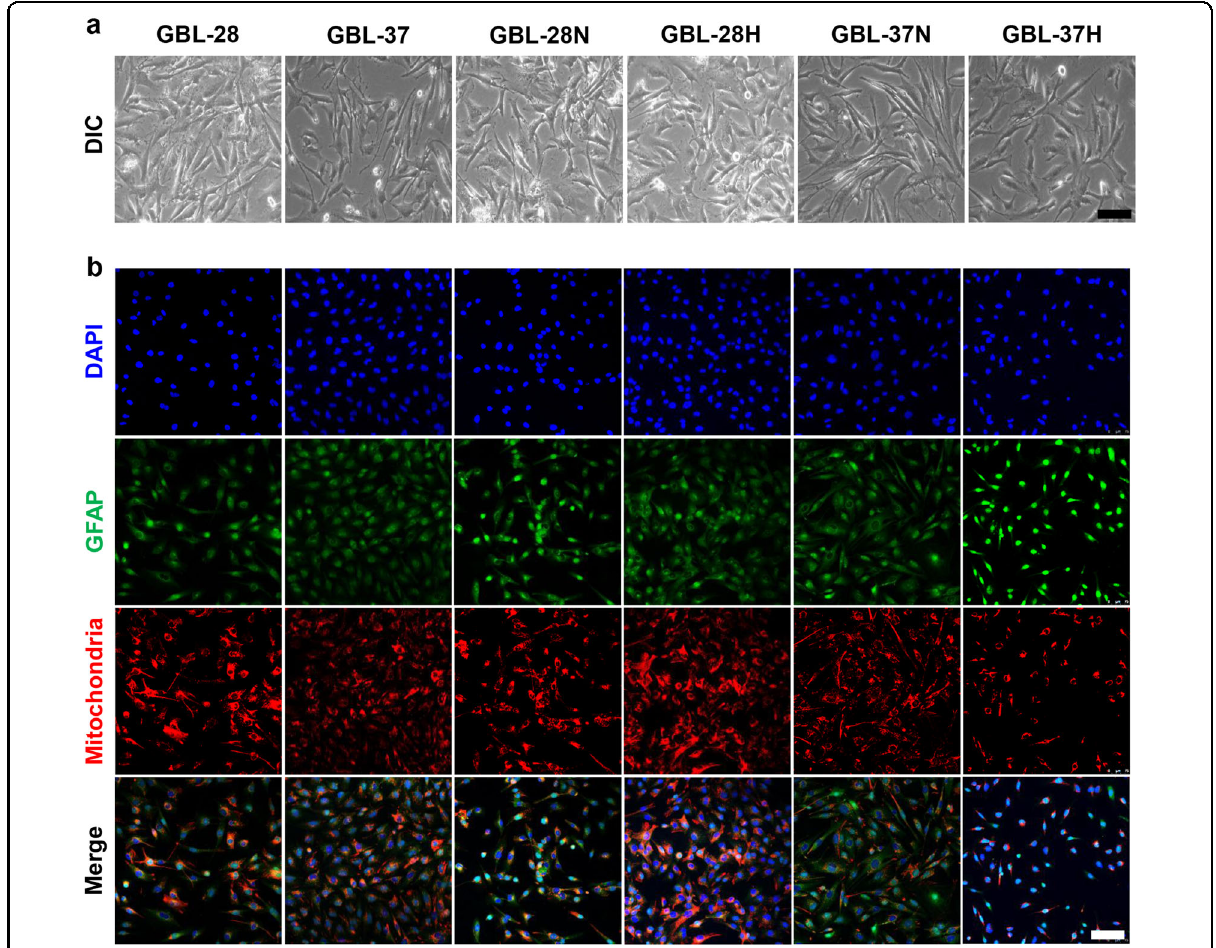
Fig. 5 Isolation and characterization of tumor cells from the vitreous cavity of mice. a Representative images of glioblastoma cells. b Representative images of glioblastoma cells that were stained using DAPI and antibodies speci fi c for GFAP and human mitochondria. GBL-28N and GBL-37N, cells isolated from mice at 4 weeks after the intravitreal injection of GBL-28 and GBL-37 cells that underwent normal culture conditions. GBL-28H and GBL-37H, cells isolated from mice at 4 weeks after the intravitreal injection of GBL-28 and GBL-37 cells that underwent hypoxia treatment for 4 h before injection. Scale bar: 100 μ